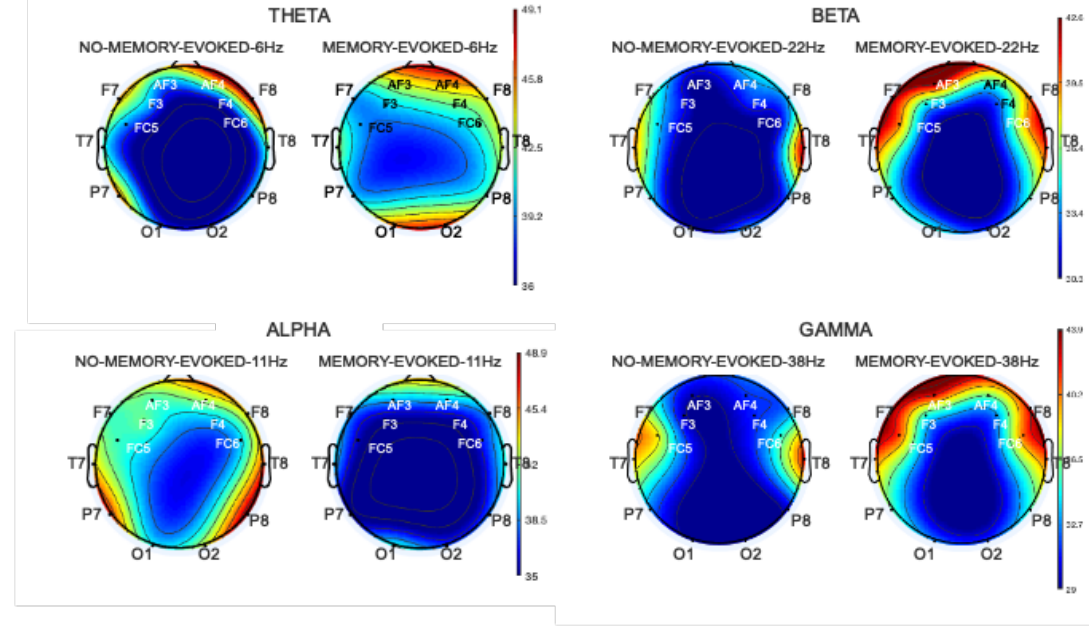
Figure 7. Spectral power map for the different frequency bands using six valid